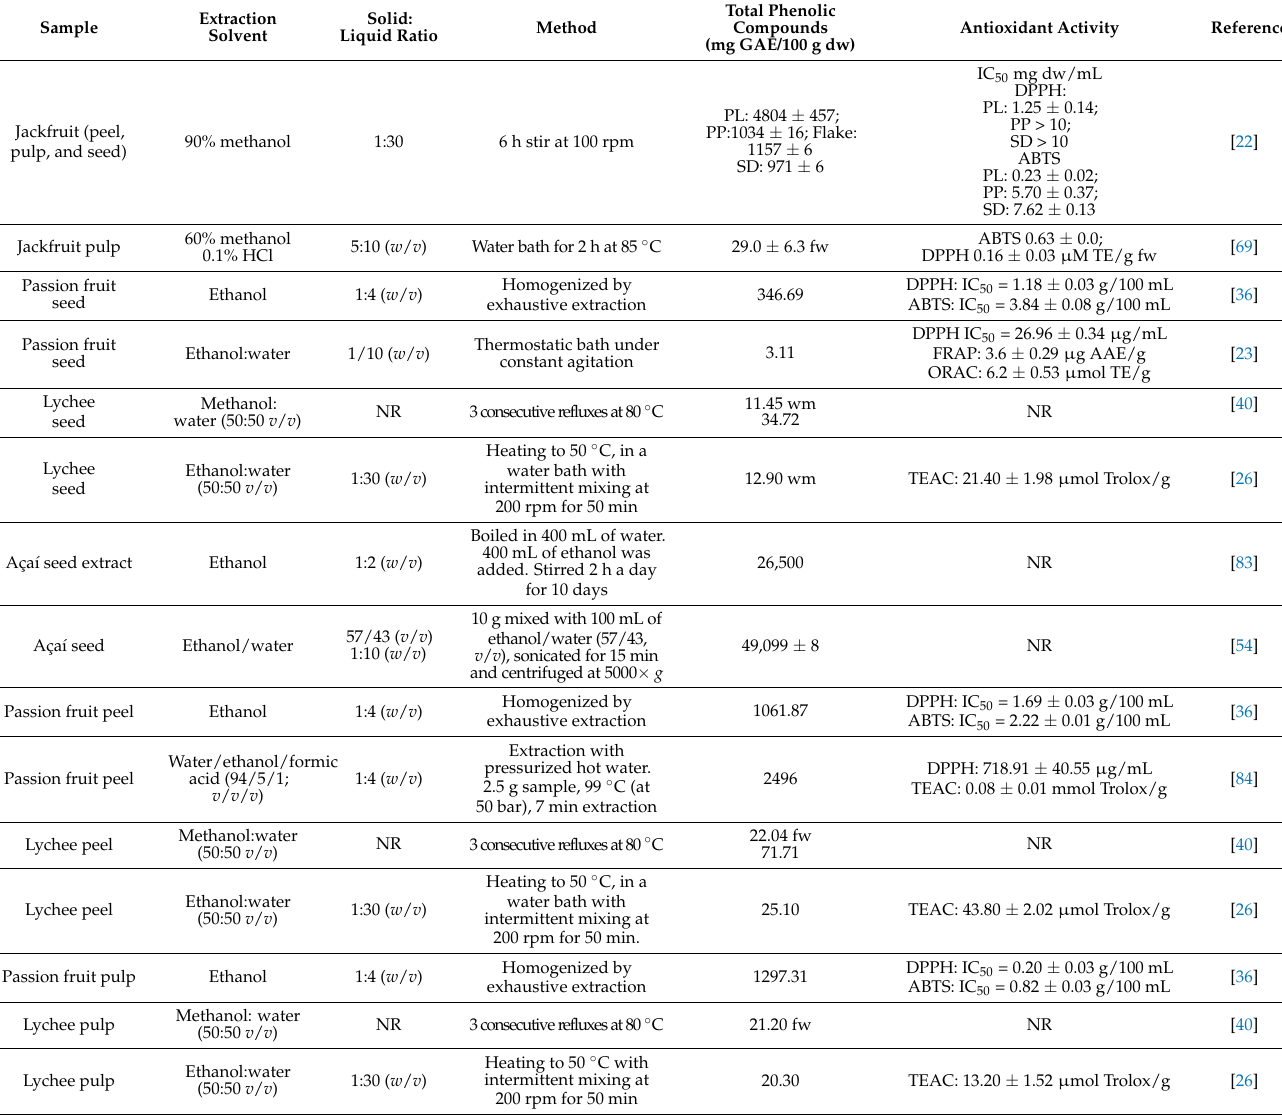
Table 3. Total phenolic compounds present in the pulp, seed, and peel of mamey, aça í , passion fruit, lychee and jackfruit, and their antioxidant